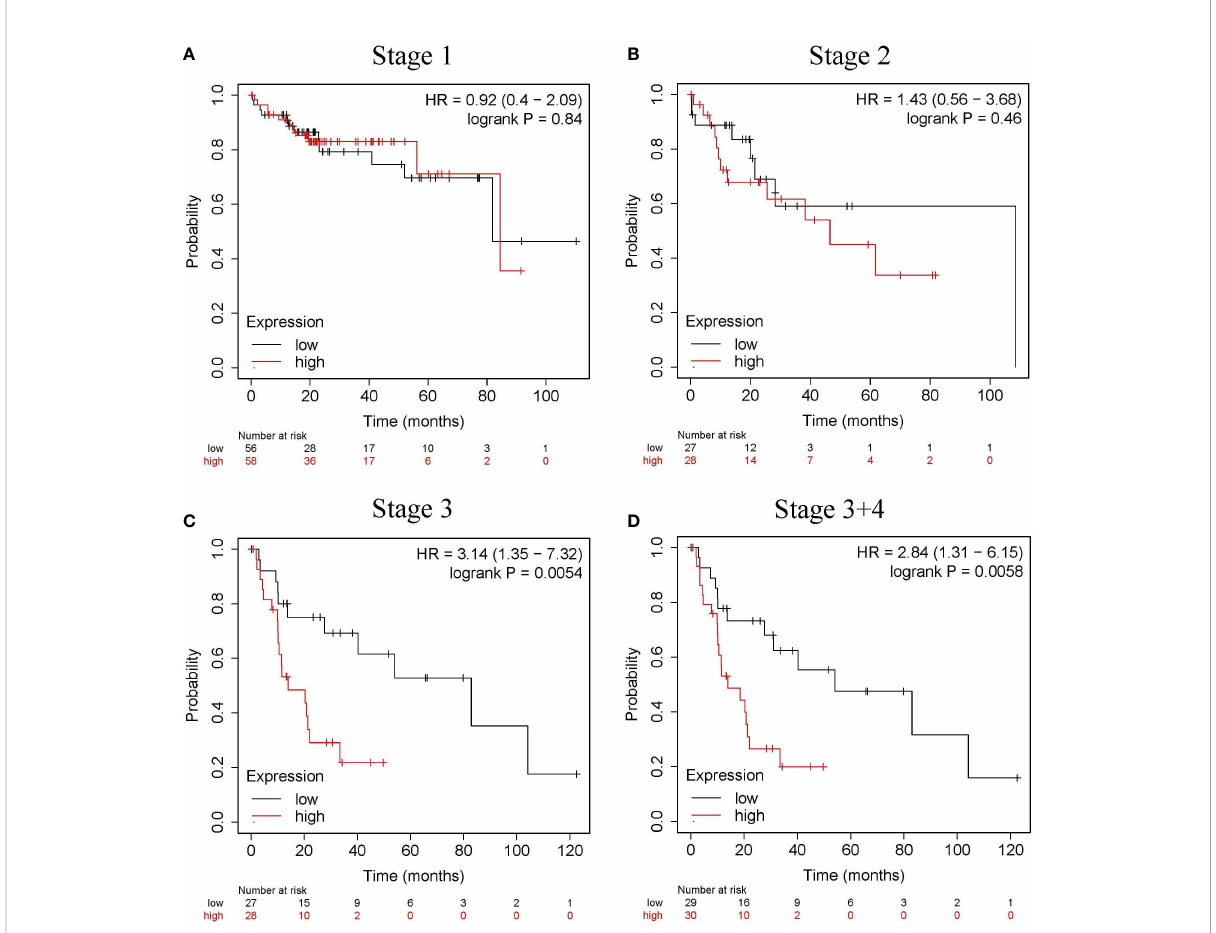
FIGURE 6 The relationship between the CLGN mRNA level and the OS in different pathology stages in HCC patients. (Kaplan Meier Plotter). (A, B) There was no signi fi cant correlation between the CLGN mRNA level and the OS in HCC patients in early stages (T1 and T2), p > 0.05. (C, D) HCC patients in advanced T stages (T3 and T3+T4) have higher CLGN mRNA expression and poorer OS, p < 0.05.